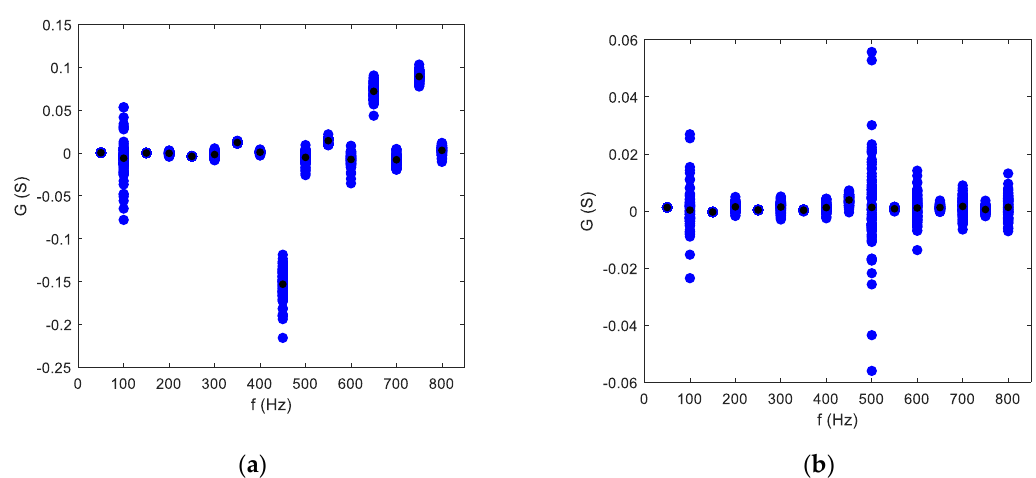
Figure 18. Conductance harmonics (102 – 117) of ( a ) LED bulb; ( b ) incandescent bulb.